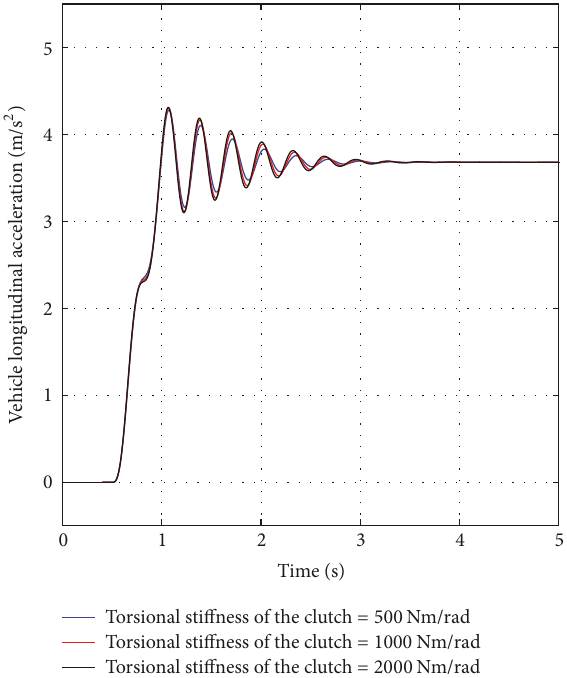
Figure 7: Sensitivity analysis: effect of the variation of the torsion stiffness 𝑘 𝑐 of the clutch.